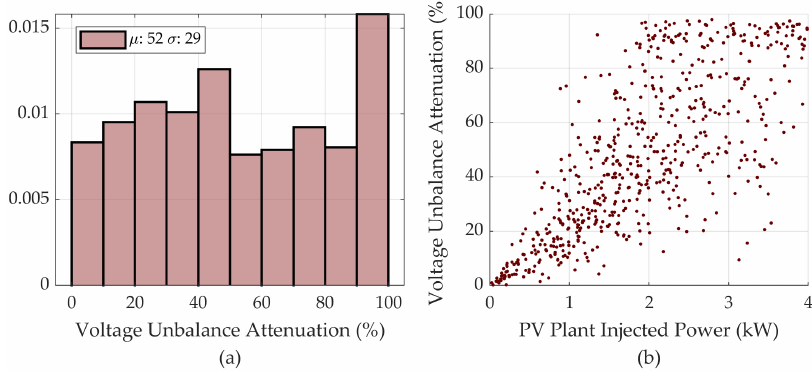
Figure 8. Voltage unbalance attenuation at strategy 3 ( a ) and corresponding PV injection ( b